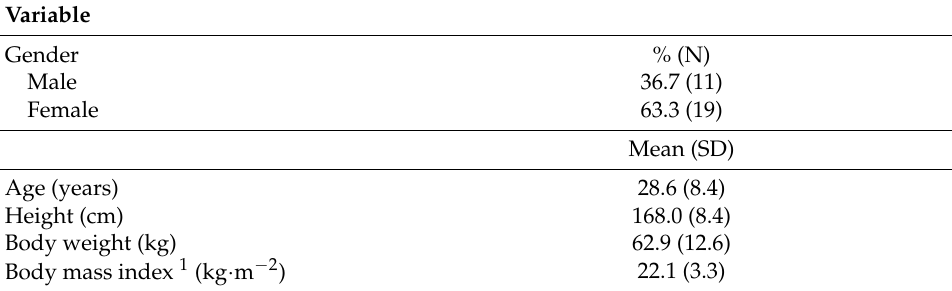
Table 1. Descriptive characteristics of the participants (N = 30).